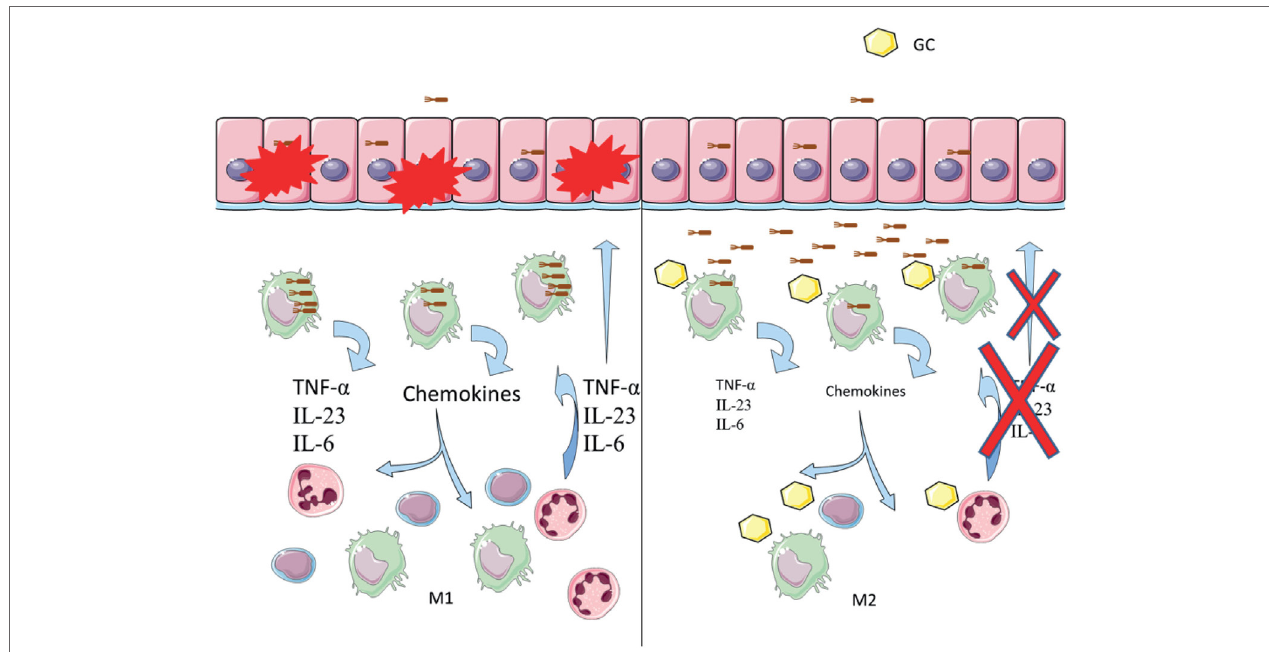
FigUre 9 | Glucocorticoids induce inhibition of phagocytosis in Crohn’s disease (CD). Left: the proposed model of disease indicates that bacteria such as adherent-invasive Escherichia coli (AIEC) may trigger or maintain inflammation in the gut mucosa. AIEC can infect and cross the epithelial barrier, being afterward phagocytosed by residing macrophages. Increased survival of AIEC inside macrophages induces secretion of chemokines and cytokines. Immune cells are recruited, increasing the inflammatory response and epithelium damage. Right: proposed model of glucocorticoid inducing chronicity in CD. Glucocorticoid treatment may decrease phagocytosis of AIEC by macrophages, impairing bacterial clearance. Decreased inflammatory response affects cell recruitment, which may then die through glucocorticoid-induced apoptosis. A low-grade inflammatory environment protects from epithelium damage but increases AIEC’s chances of survival, which likely perpetuates the